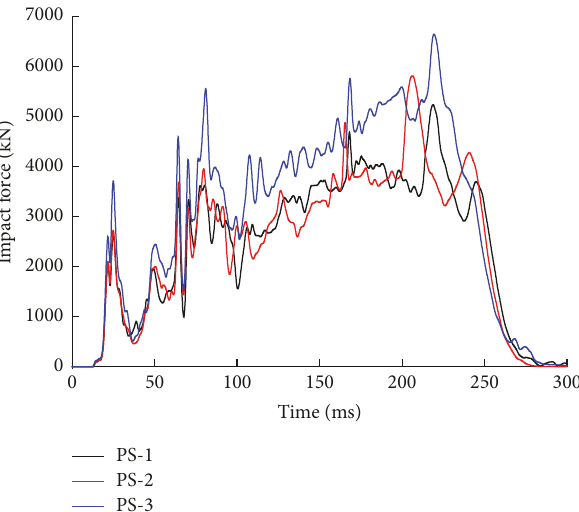
Figure 22: Impact force time-history curves under different steel strengths.